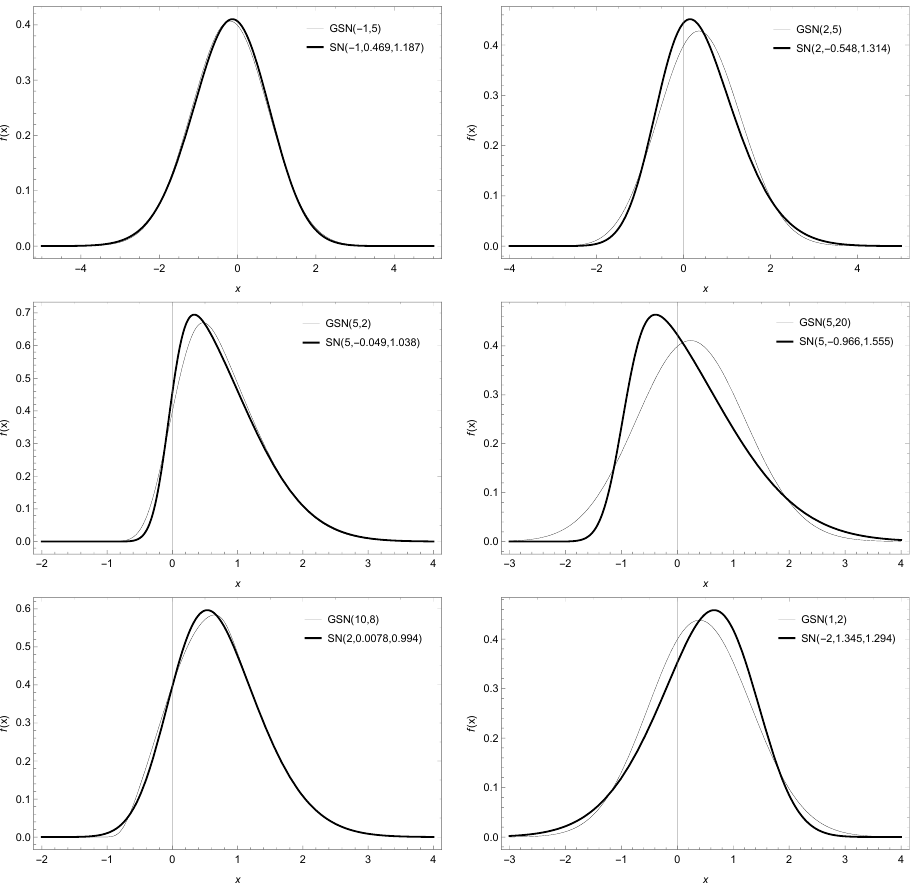
Figure 1. Plot of the pdf (4) (thick line) denoted as GSN( λ , α ) and the SN( λ , µ , σ ) (thin line) for selected values of the param- eters α and λ